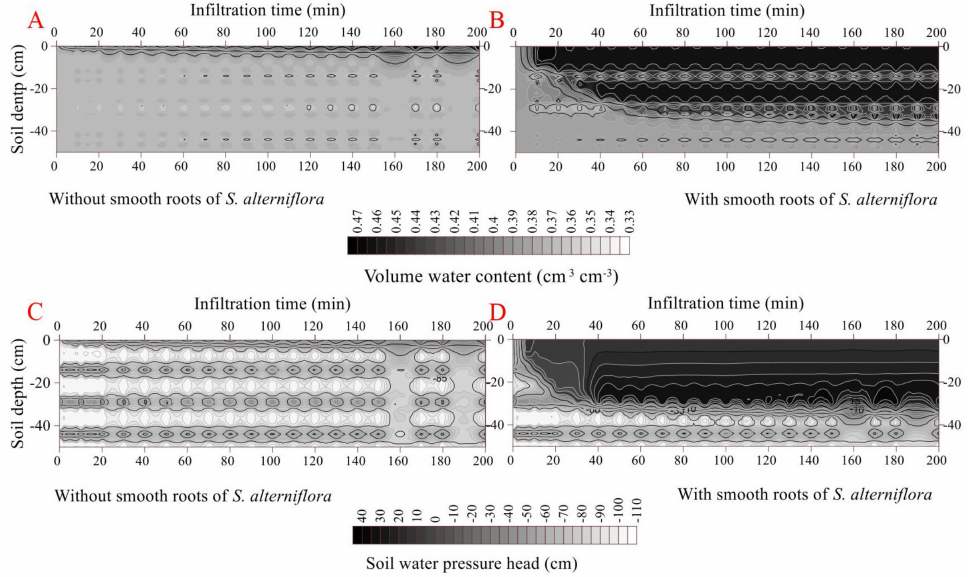
Figure 7. Dynamic characteristics of volumetric water content and soil water pressure head as a function of infiltration time in the soil profile without smooth roots of S. alterniflora ( A , C ) Dynamic characteristics of volumetric water content and soil water pressure head as a function of infiltration time in the soil profile with smooth roots of S. alterniflora ( B , D